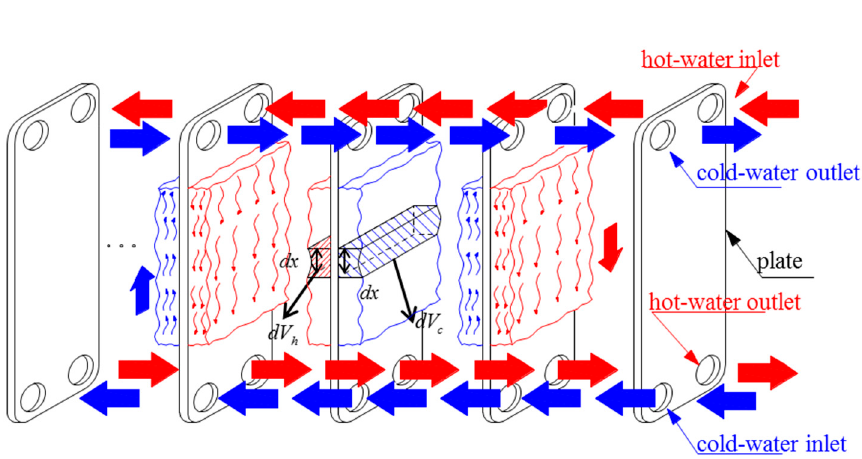
Figure 1. Heat transfer process of the plate heat exchanger (PHE).